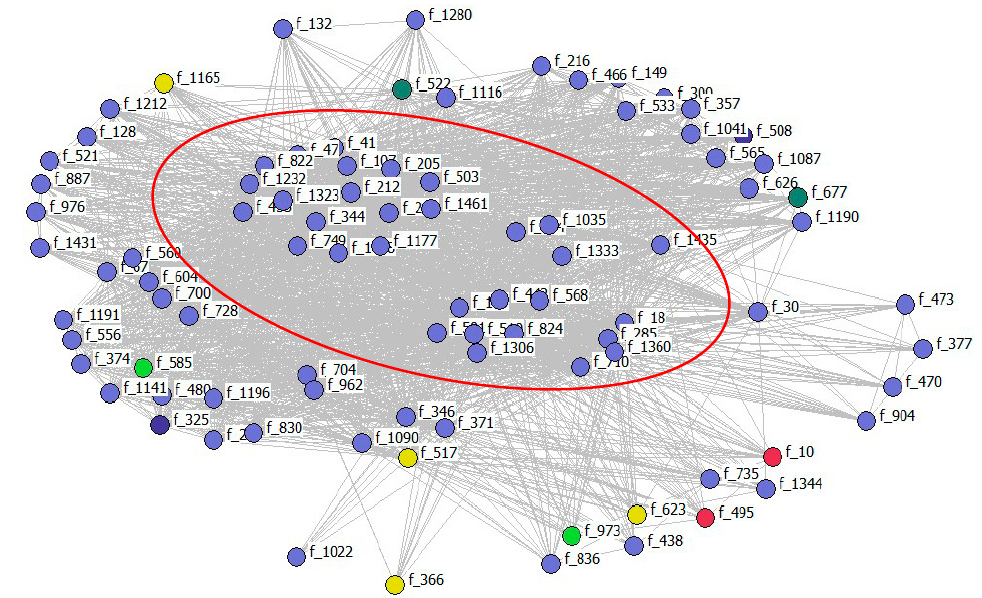
Figure 2. One-mode network visualization of farmers with a level of technological adoption greater than 40%. Nodes’ colour: organization type. Farmer code (f_n i ), organization type: